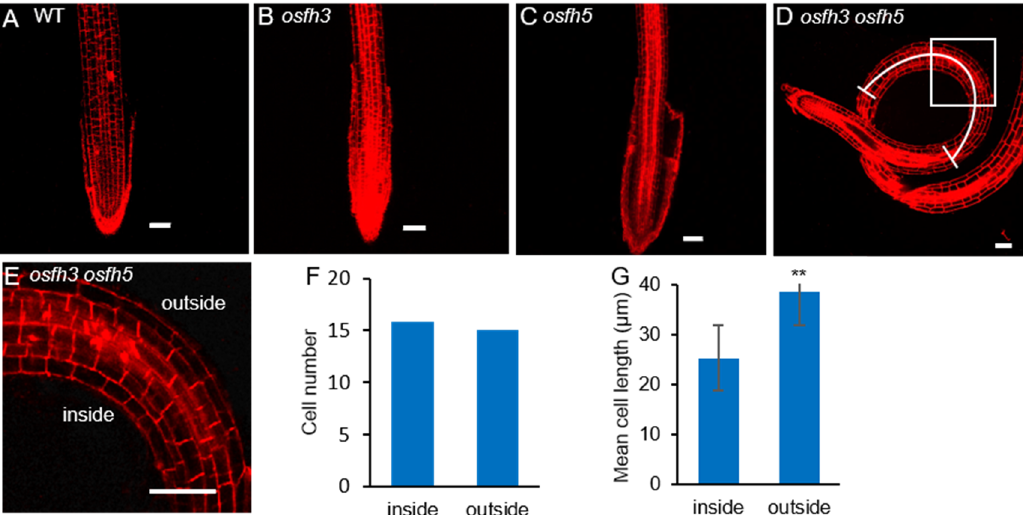
Figure 2. Propidium iodide staining results of WT, osfh3 , osfh5 , and osfh3 osfh5 roots tips. ( A – D ) WT, osfh3 , osfh5 , and osfh3 osfh5 roots tips were stained with propidium iodide. Bar = 50 µm. ( E ) Enlarged pictures of boxes in the D pictures. ( F ) Cell number statistic of curved segment in osfh3 osfh5 roots. n = 10. ( G ) Cell length statistic of curved segment in osfh3 osfh5 roots. The arc in D marks the data source area in the root. n = 100. ** p < 0.01, Student’s t -test.